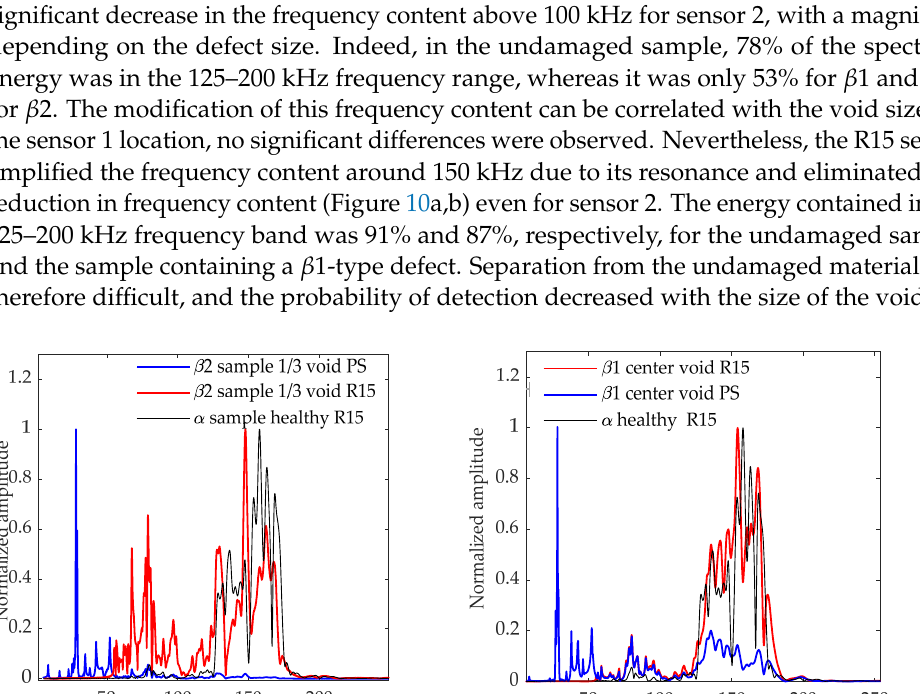
Figure 9. FFT of the simulated signals recorded by the perfect sensor (PS): ( a ) sensor location 2; ( b ) sensor location 1.